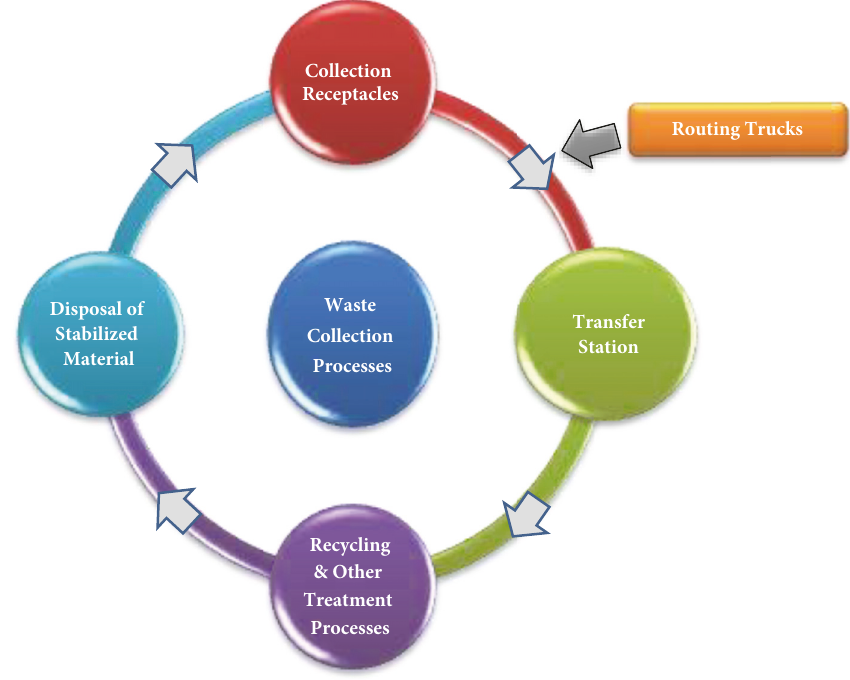
Figure 2: Solid waste collection and transportation